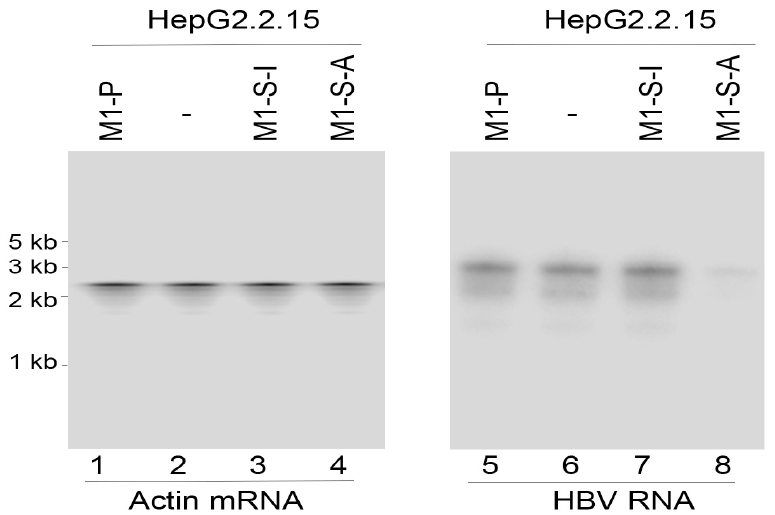
Figure 2. HBV transcript expression assayed by Northern blot analyses. RNA samples (25 µg) from cells containing the empty vector pU6 (-, lanes 2 and 6), pU6-M1-P (lanes 1 and 5), pU6-M1-S-I (lanes 3 and 7), and pU6-M1-S-A (lanes 4 and 8), were separated on agarose gels, transferred to nitrocellulose membranes, and hybridized to [ 32 P]-radiolabeled probes specifically for the actin mRNA (loading control) (lanes 1–4) and HBV S mRNA (lanes 5–8).